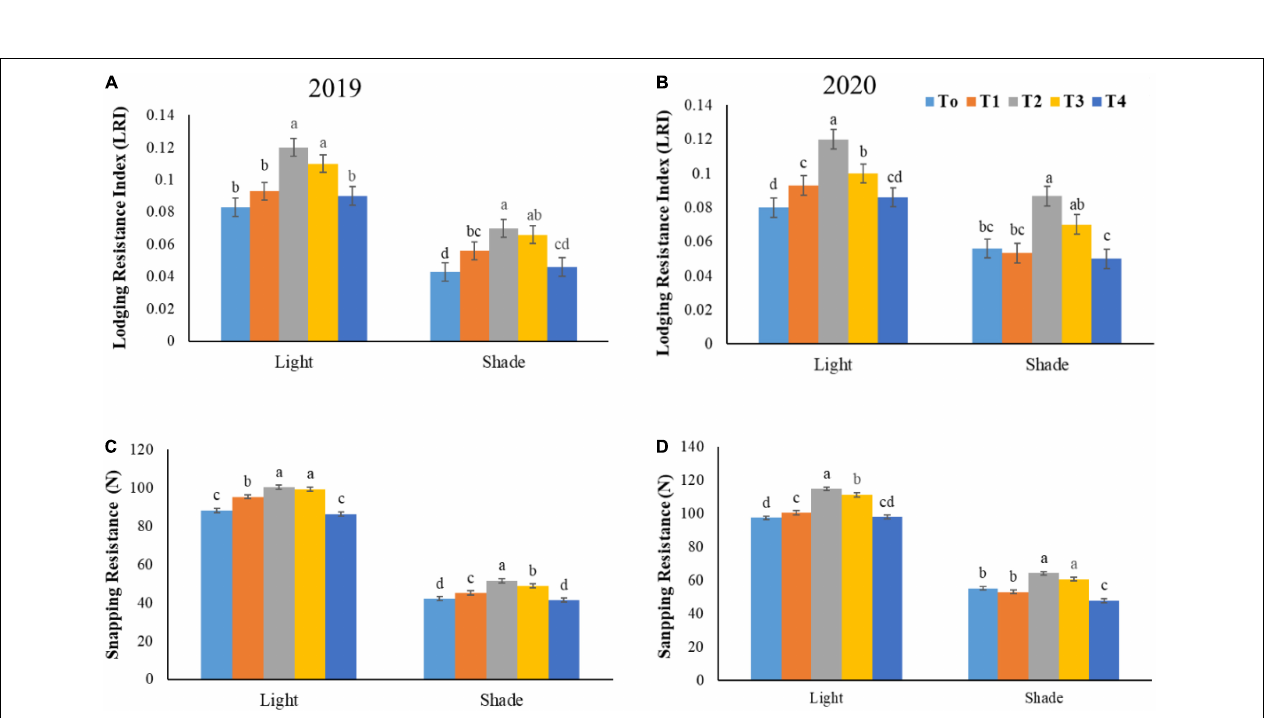
FIGURE 6 | Effect of various NH 4 + /NO 3 − ratios on lodging resistance index (A,B) , and snapping resistance (C,D) under light and shade. Different treatment levels T0, T1, T2, T3, and T4 characterize the ratios of NH 4 + /NO 3 − 0/0, 0/100, 25/75, 50/50, and 75/25, respectively. All of the results are the mean of three replications. The bars represent the ± SD (standard deviation). A significant difference ( ∗ p < 0.05) between treatments is shown by different lowercase letters above bars.